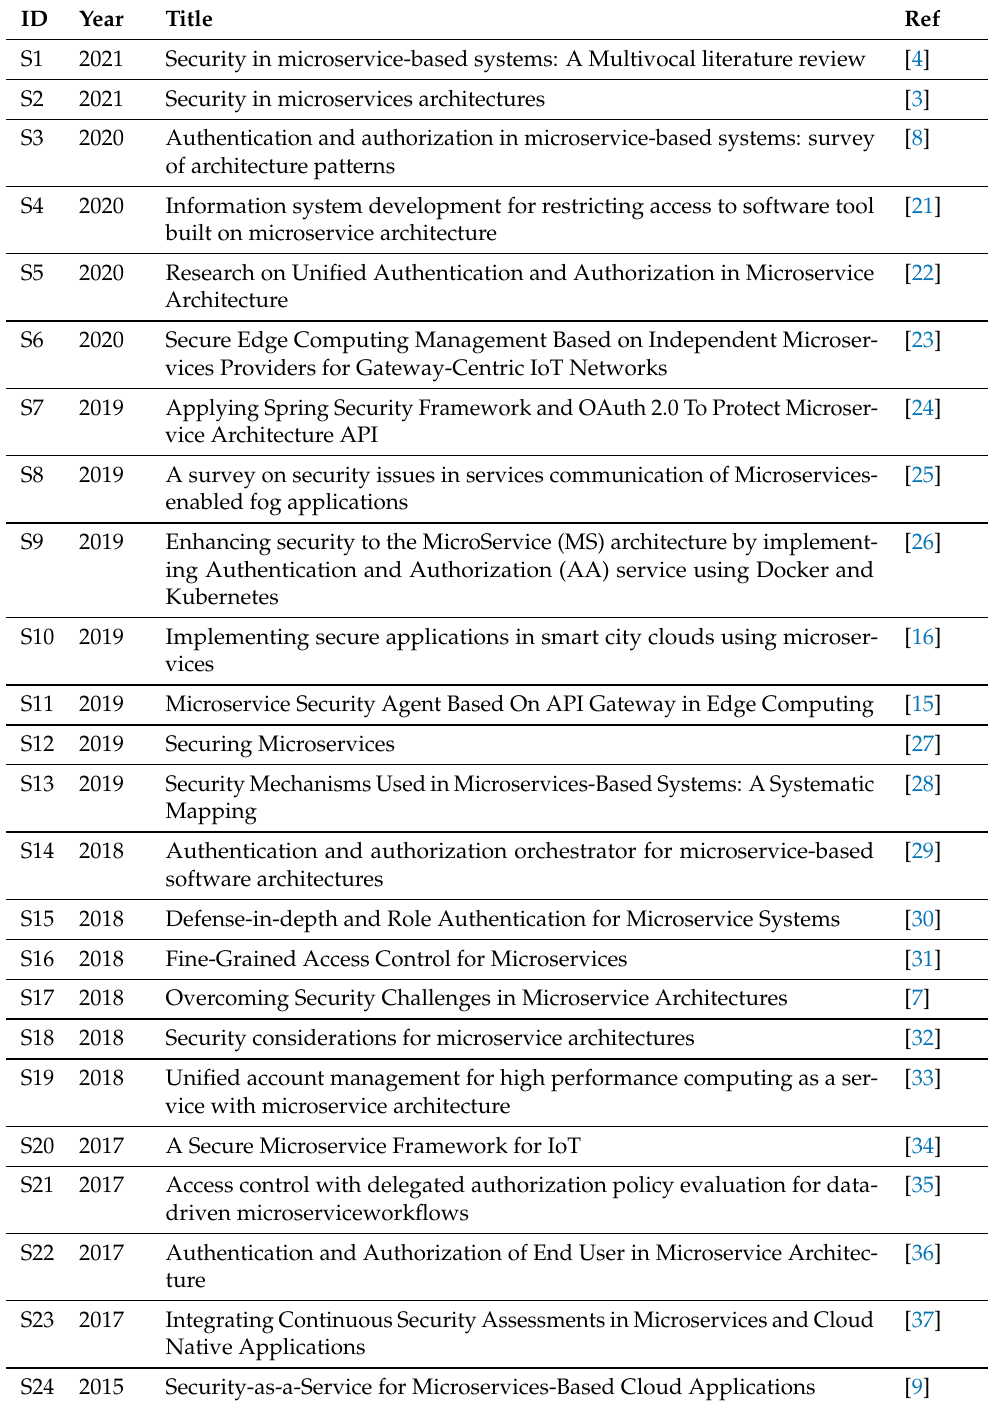
Table 1. Selected